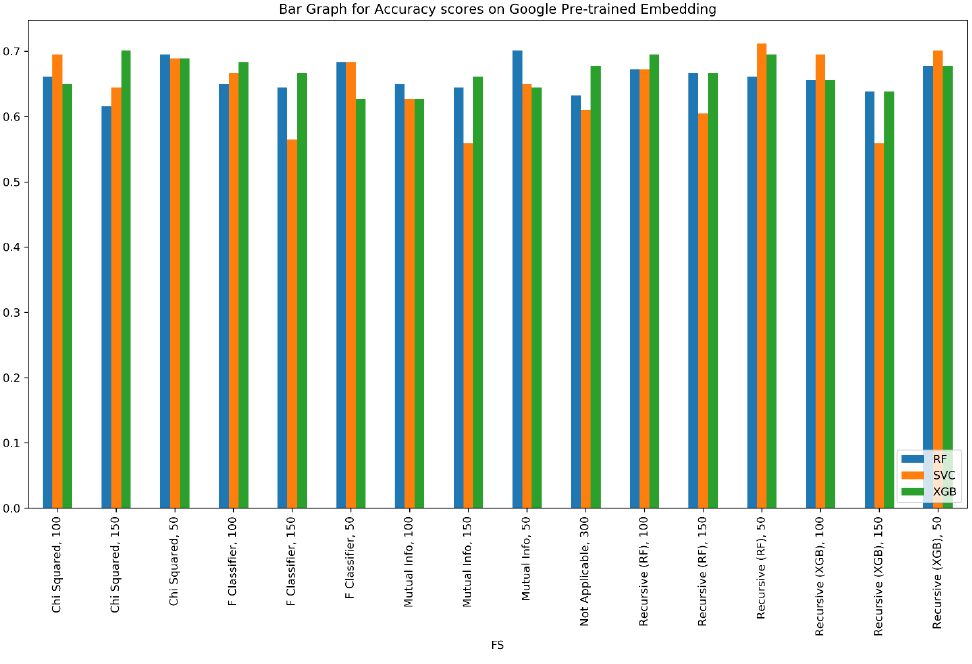
Figure 8. Bar graph for F 1 scores on Google’s pre-trained embedding, for all combinations of feature selection methods and number of